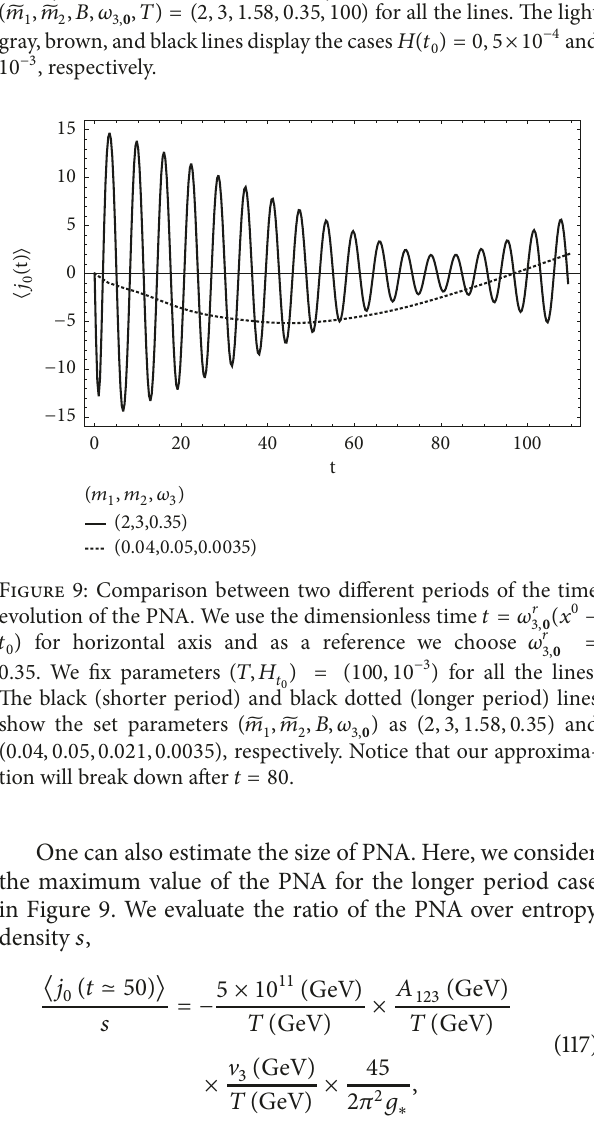
= 0.35 . We fix parameters as 3, 0